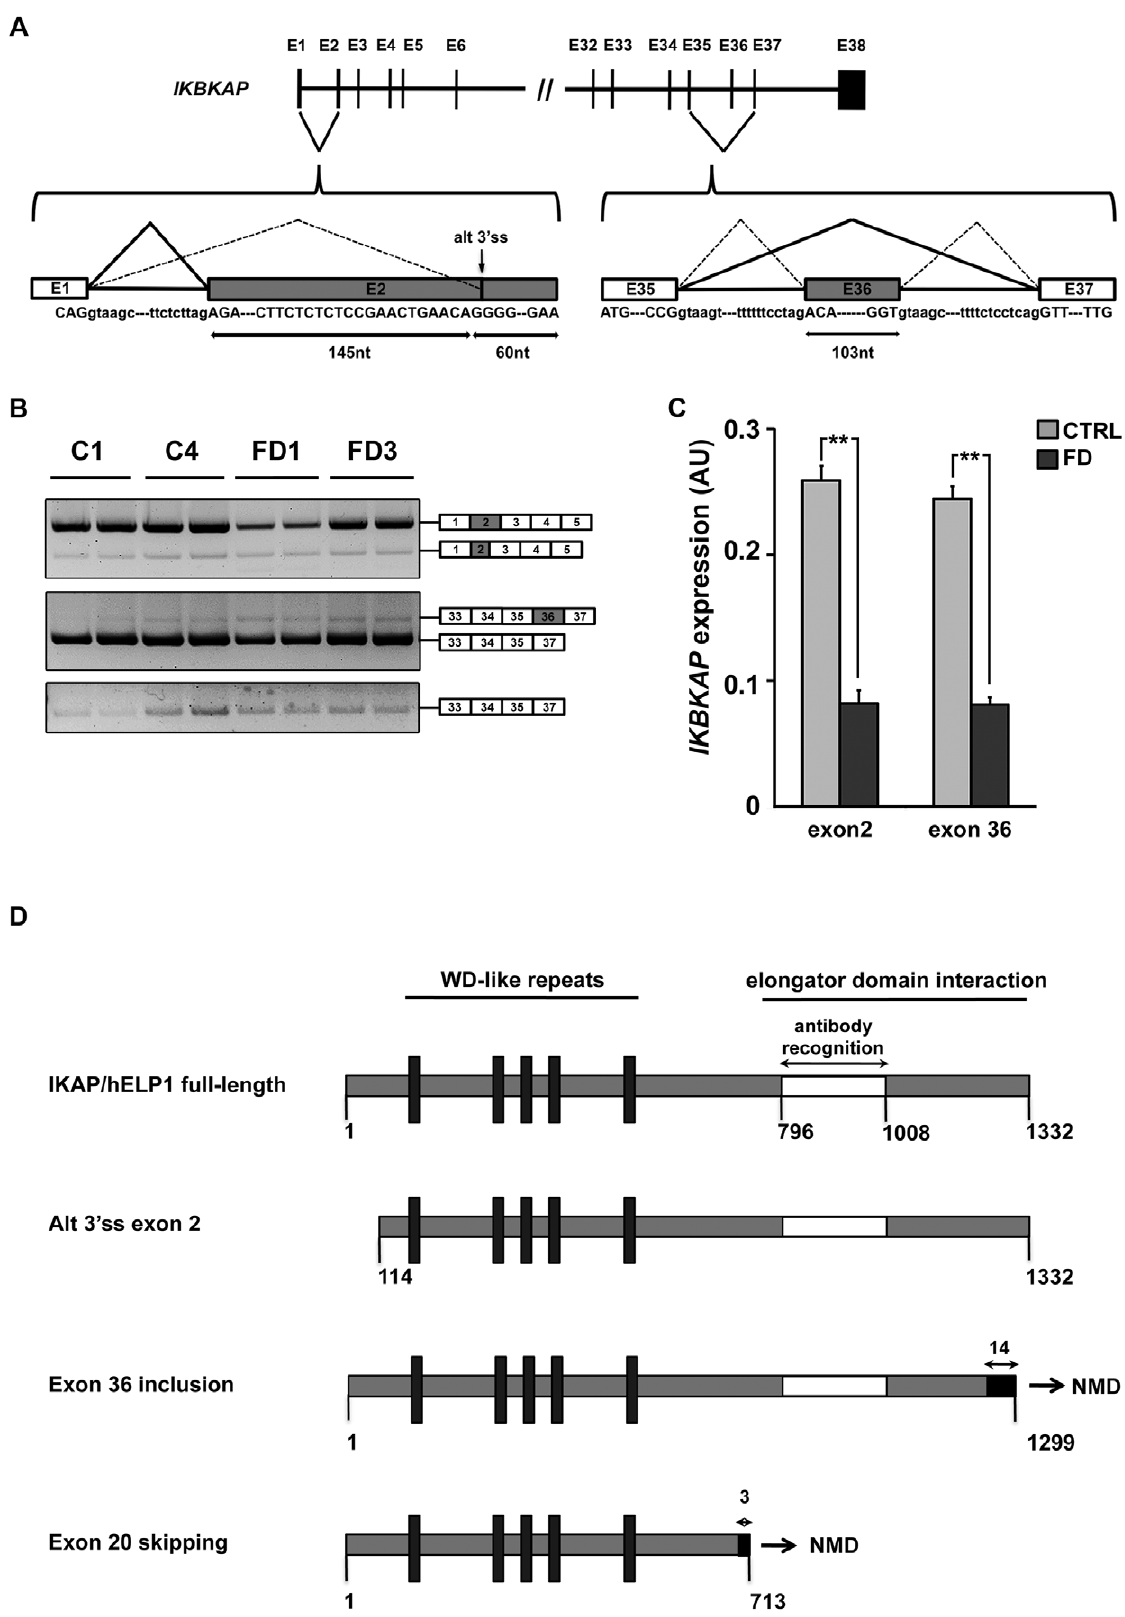
Figure 6. Expression and alternative splicing of IKBKAP mRNA at the extremities of the coding sequence. Two additional splicing events are described within IKBKAP gene. The first one represents the alternative use of a 3 9 ss for exon 2 and the second one concerns exon 36 skipping, as